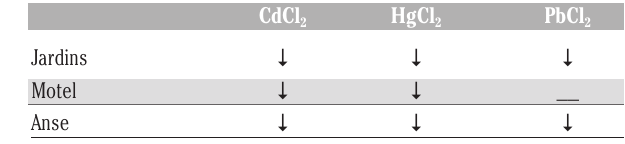
Table 1. Summary of the results obtained for phagocytic activity and efficacy when results obtained in clams collected upper shore were compared to the clams collected at middle shore. Throughout the experiment, with the exception of lead at the Motel site, results obtained in clams collected in the upper shore were significantly lower than results obtained in clams collected in the middle shore.